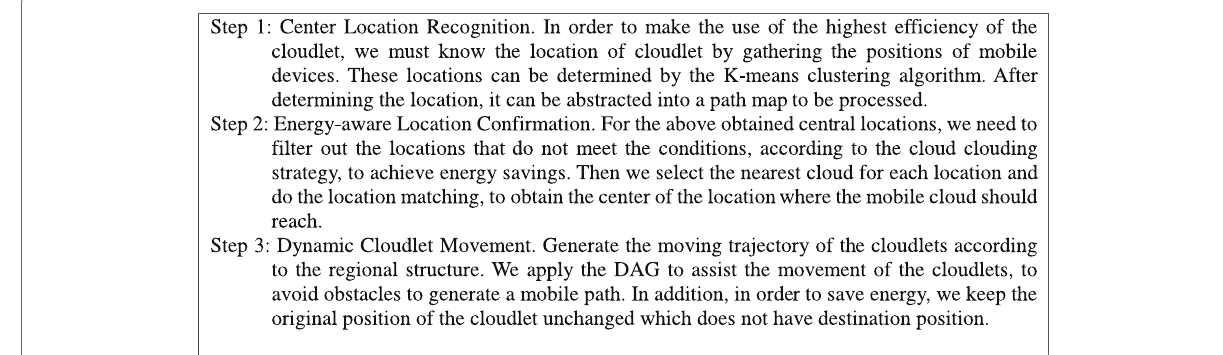
Fig. 3 Main steps of the proposed energy-efficient cloudlet placement